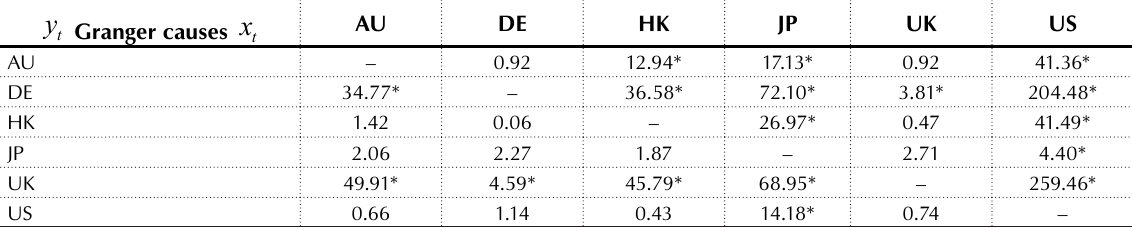
Table 6. Granger causality test for returns, post-crisis